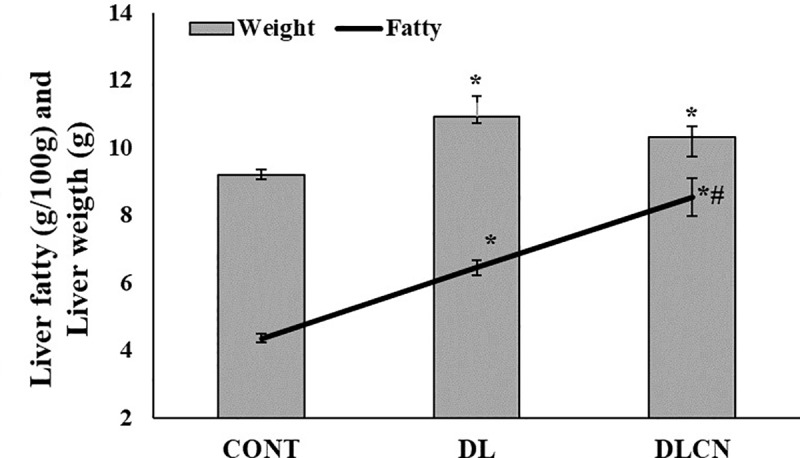
Liver fatty and liver weight of dyslipidaemic animals fed cashew nut for four weeks.Values expressed as the mean ± SEM. The groups were Control group (CONT), Dyslipidemic group (DL), Dyslipidemic Cashew Nut group (DLCN). *
versus CONT. #
versus DL. p < 0.05, as determined by One-Way ANOVA followed by the Tukey test.